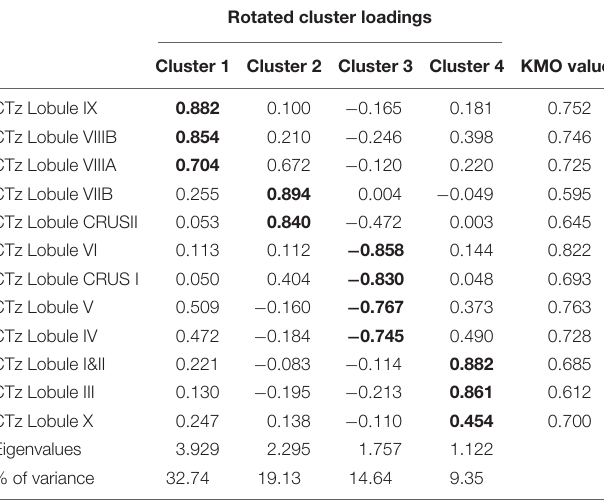
TABLE 2 | Pattern matrix of PCA results for cerebellar lobar values of Cortical Thickness (CT) of 94 subjects [66 patients with ALS and 24 healthy controls